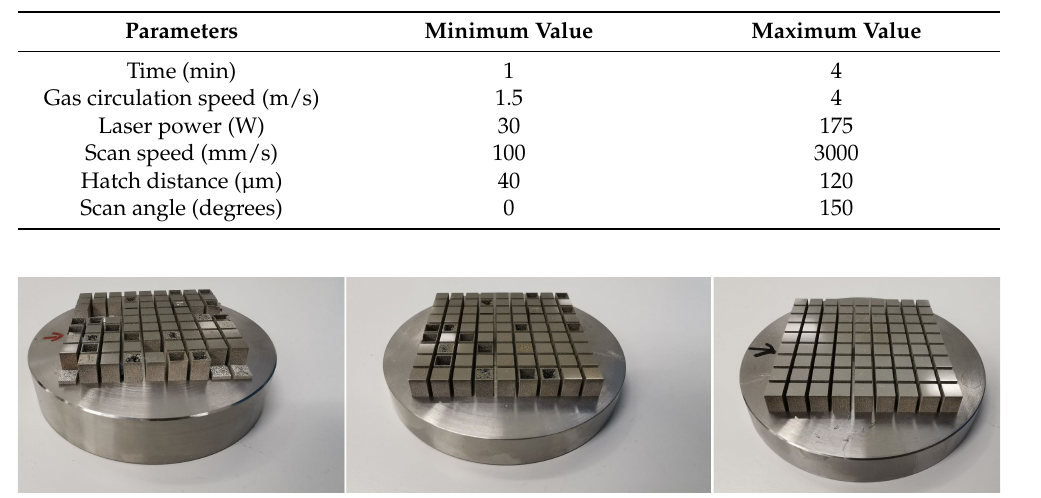
Table 1. Process parameter range.